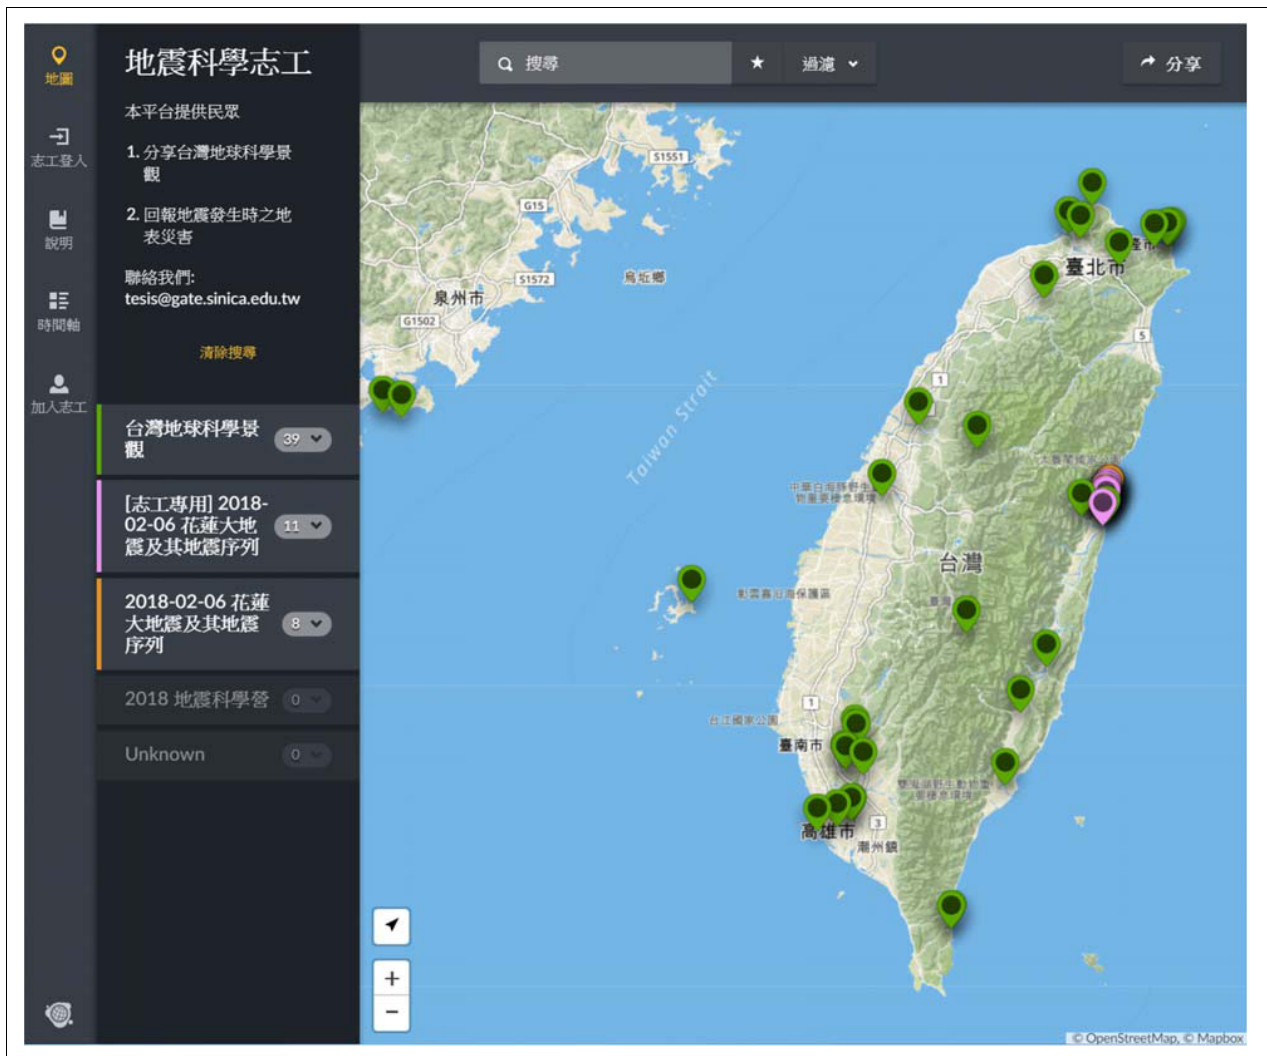
FIGURE 4 | The home page of the TSER portal page. Each small balloon represents geographical site of individual reports for either earthquake-triggered surface natural damages (pink color) or geological landscape (green